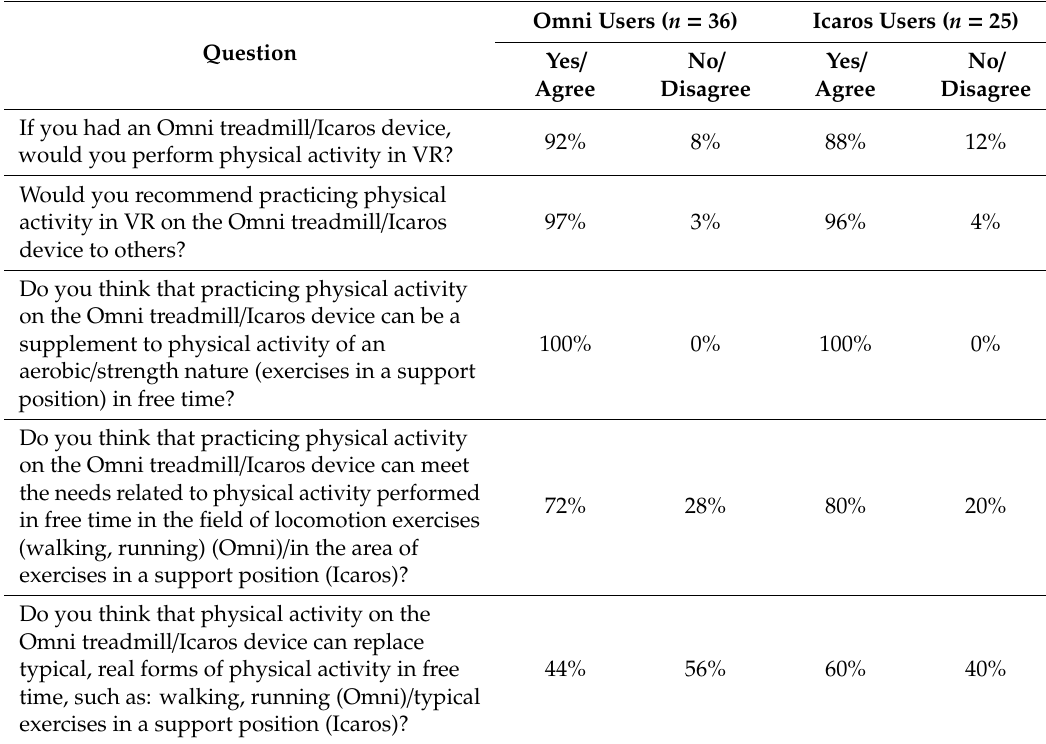
Table 1. Usefulness of physical activity in VR using innovative training devices (omni-directional Omni treadmill and Icaros Pro flight simulator) in the assessment of study